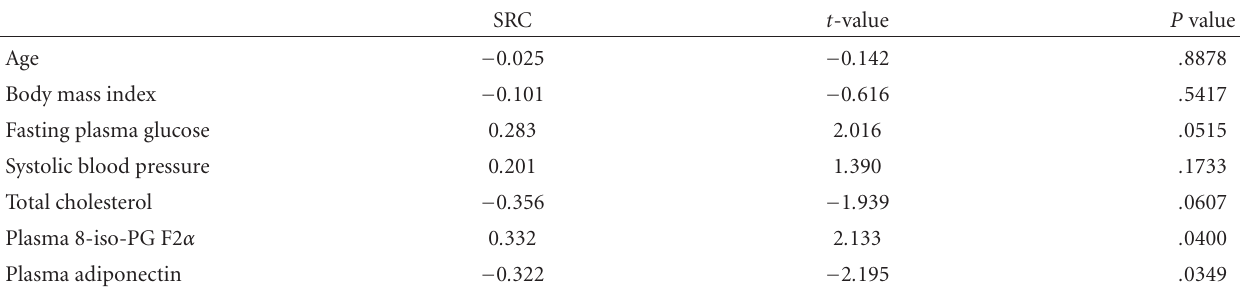
Table 2: Multivariate regression analysis for predicting order parameter ( S ) of